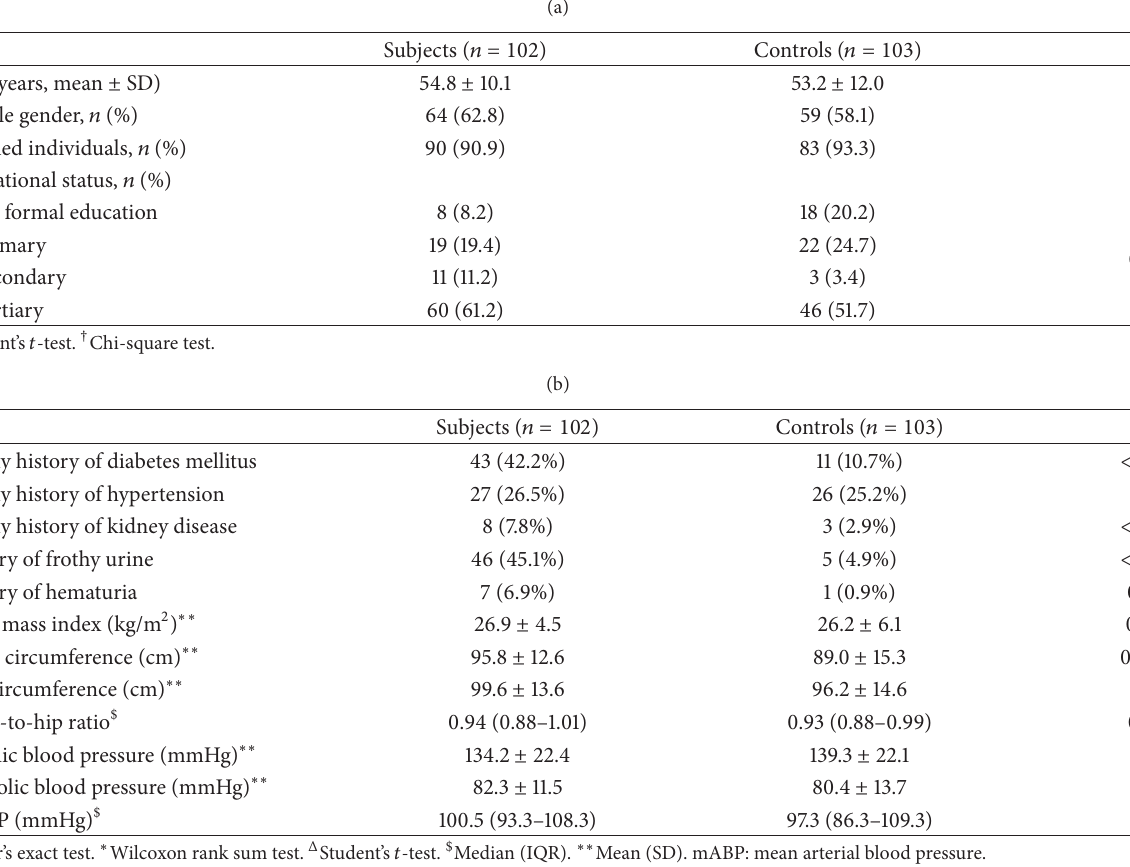
Table 1: Comparison of sociodemographic/clinical characteristics of subjects and controls.